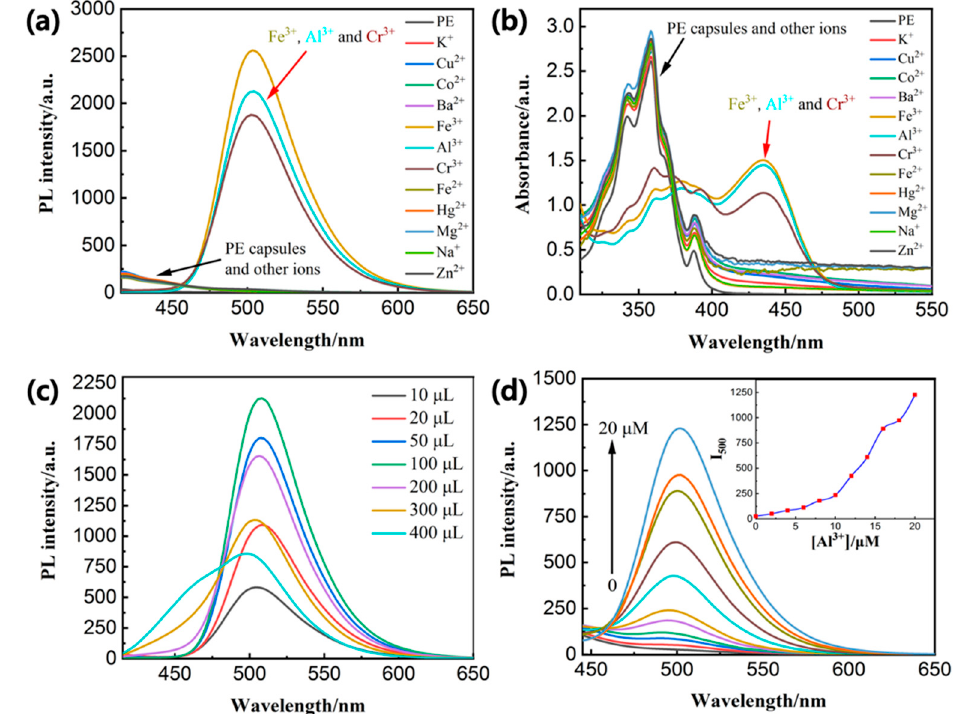
Figure 8. ( a , b ) Fluorescence responses ( λ ex = 395 nm) and UV–Vis responses of the released PE/MNP microcapsules (2 mg in 10 mL CH 3 CN) towards 50 μ M of various metal ions in H 2 O. ( c ) PL spectra of released PE/MNPs microcapsules (2 mg in 10 mL CH 3 CN) as a function of the increasing volume of 50 μ M Al 3+ in water ( λ ex = 395 nm) from 10 to 400 μ L. ( d ) PL ( λ ex = 395 nm) titrations of released PE/MNP microcapsules (2 mg in 10 mL CH 3 CN) with Al 3+ in water with an equal span of 2 μ m; PL inset: intensity changes at 500 nm towards Al 3+ concentration.